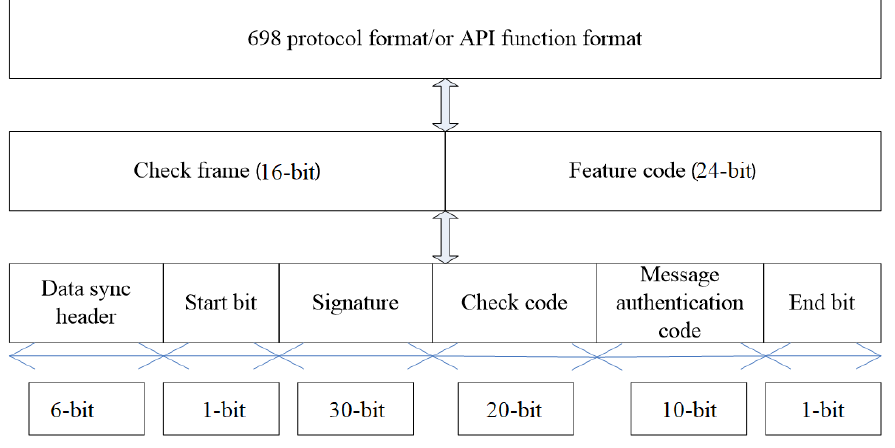
Figure 9. Packet encapsulation format.